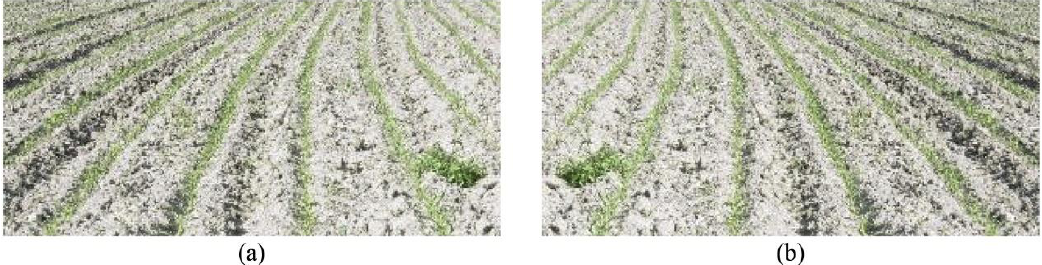
Figure 17. Two examples of region of interest (ROI) (a) and (b) taken from a study by García-Santillán et al. (2017). The ROIs present almost no background noise as compared to our proposed study sites (Figure